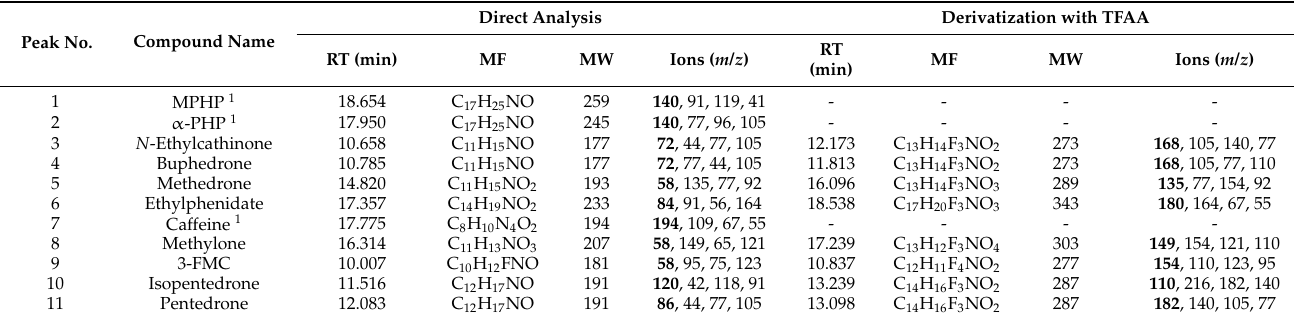
Table 2. Active substances detected by GC-MS, with the respective retention times (RT), molecular formula (MF), molecular weight (MW), base peak and other characteristic ions. Peak No.